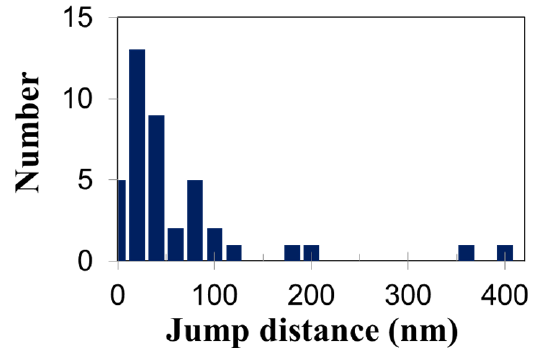
Figure 6. Dislocation motion distance distribution in irradiation sample 1.